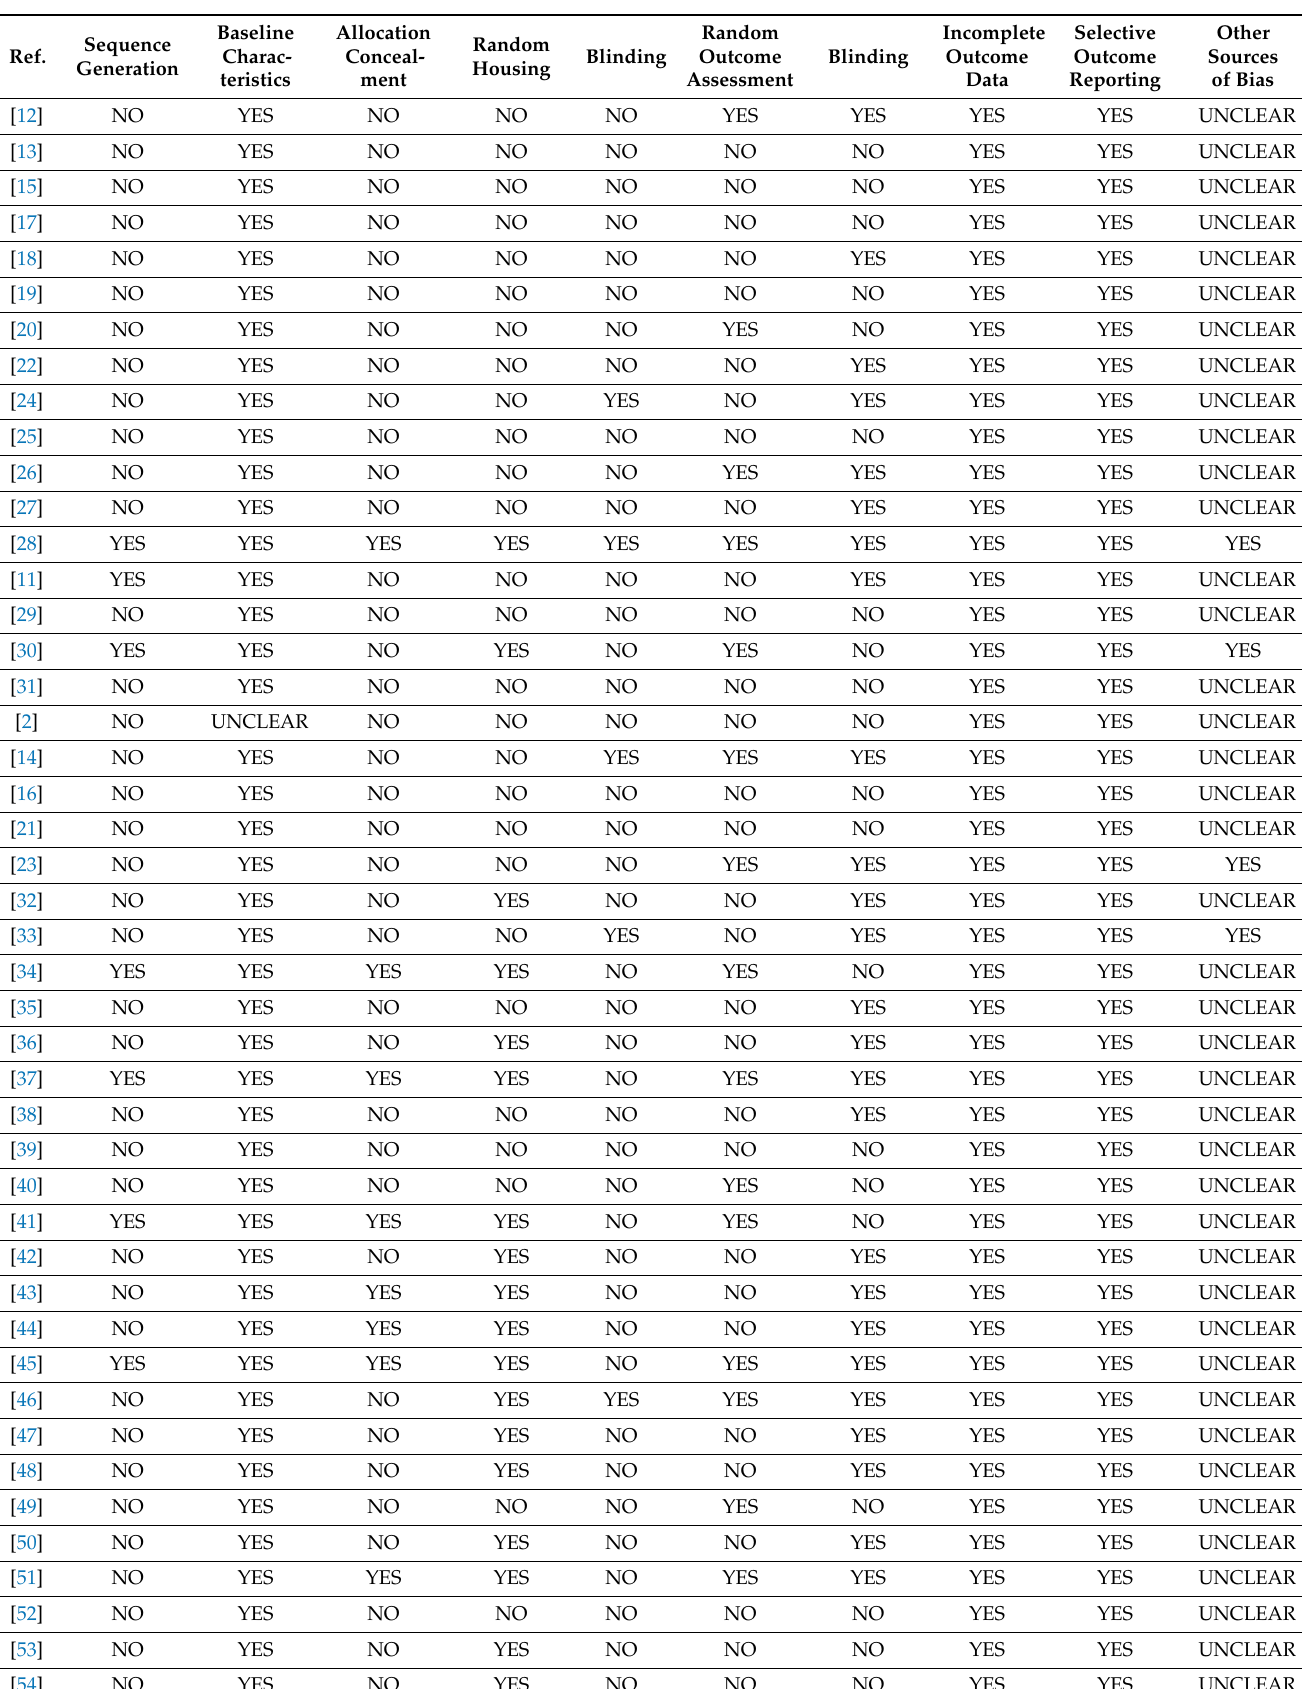
Table 3. Risk of bias of in vivo